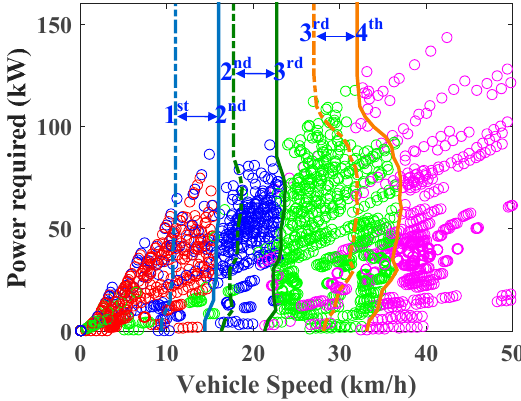
Figure 15. The optimal economic gear shifting schedule.